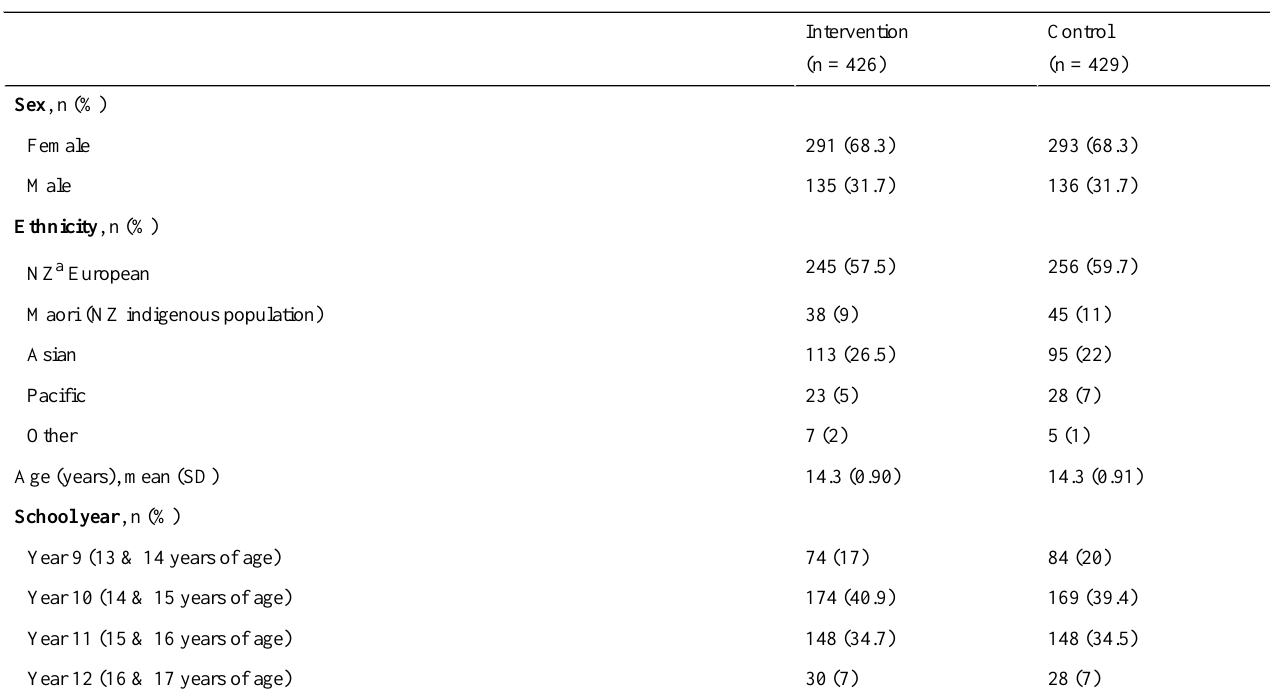
Table 1. Baseline participant